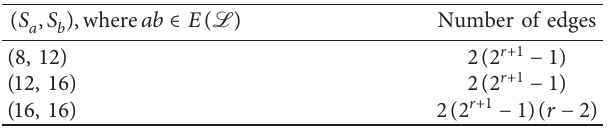
Table 5: The edge partition of graph TB ( r ) , r ≥ 4, based on degree sum of neighbor vertices of end vertices of each